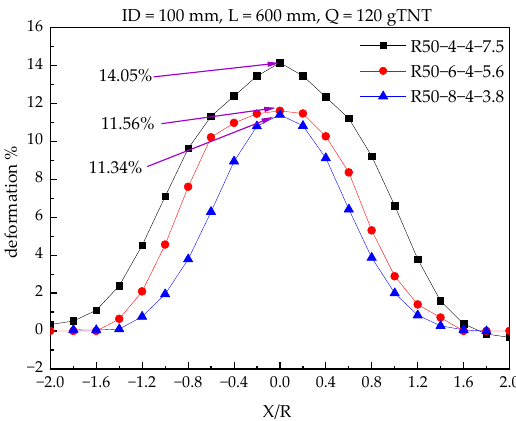
Figure 9. Inner shell deformation of double-layer shells.